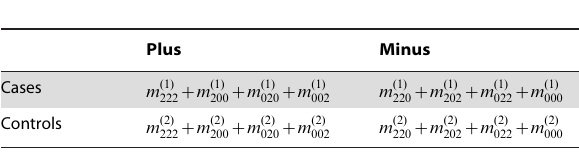
Table 2. The x 2 test statistics for the additive | additive | additive epistatic